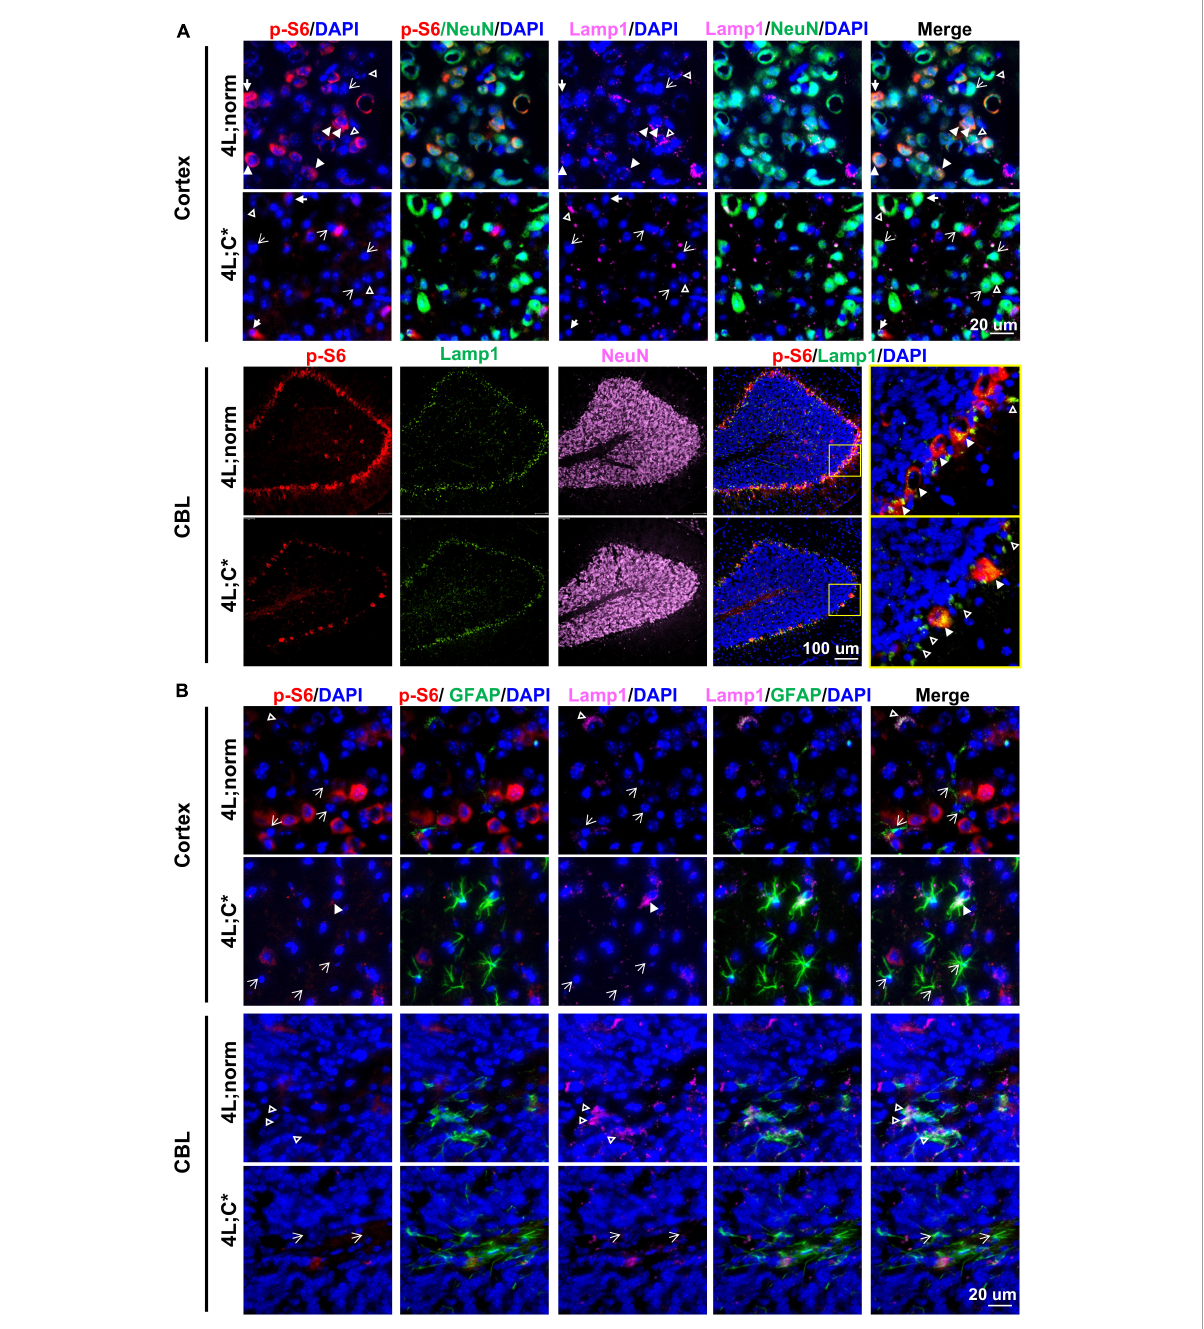
FIGURE4 Expression of p-S6 and Lamp1 in neurons and astrocytes. Representative views of p-S6 and Lamp1 signals in neurons (A) or astrocytes (B) of cortex and CBL regions. In (A) , neurons (or astrocytes in B ) with detectable Lamp1 are indicated for co-localization with (white triangles) or without (open triangles) strong p-S6 signals; neurons (or astrocytes in B ) with undetectable Lamp1 are indicated either with (solid arrows) or without (open arrows) p-S6 expression.